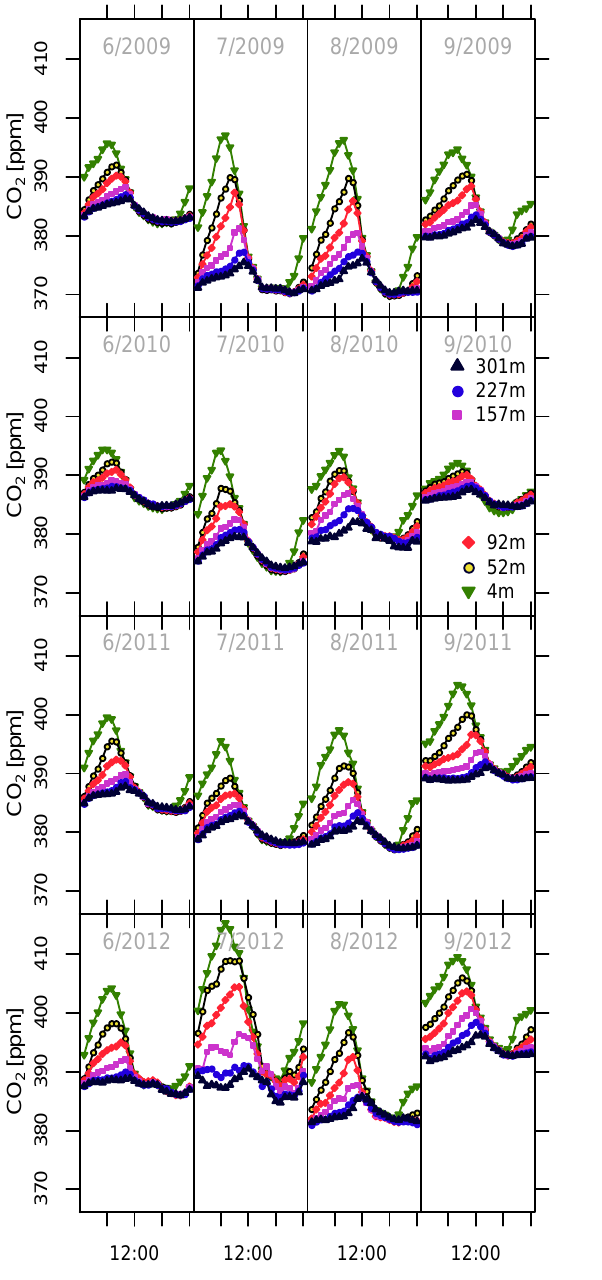
Fig. 4. CH 4 diurnal cycle, averaged for individual months and years.